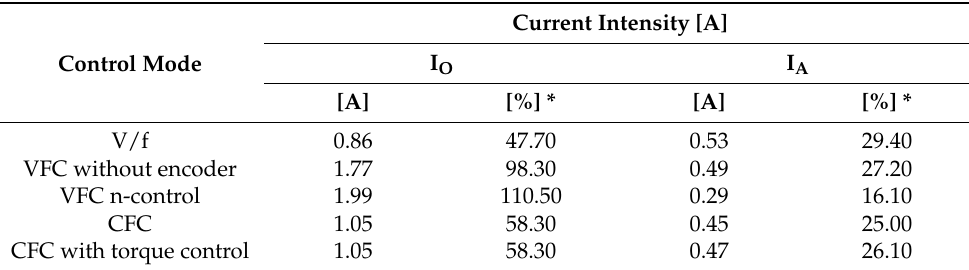
Table 4. Peak values of the output current (I O ) and the active current (I A ) of the frequency converter in a transient state (without an external load).